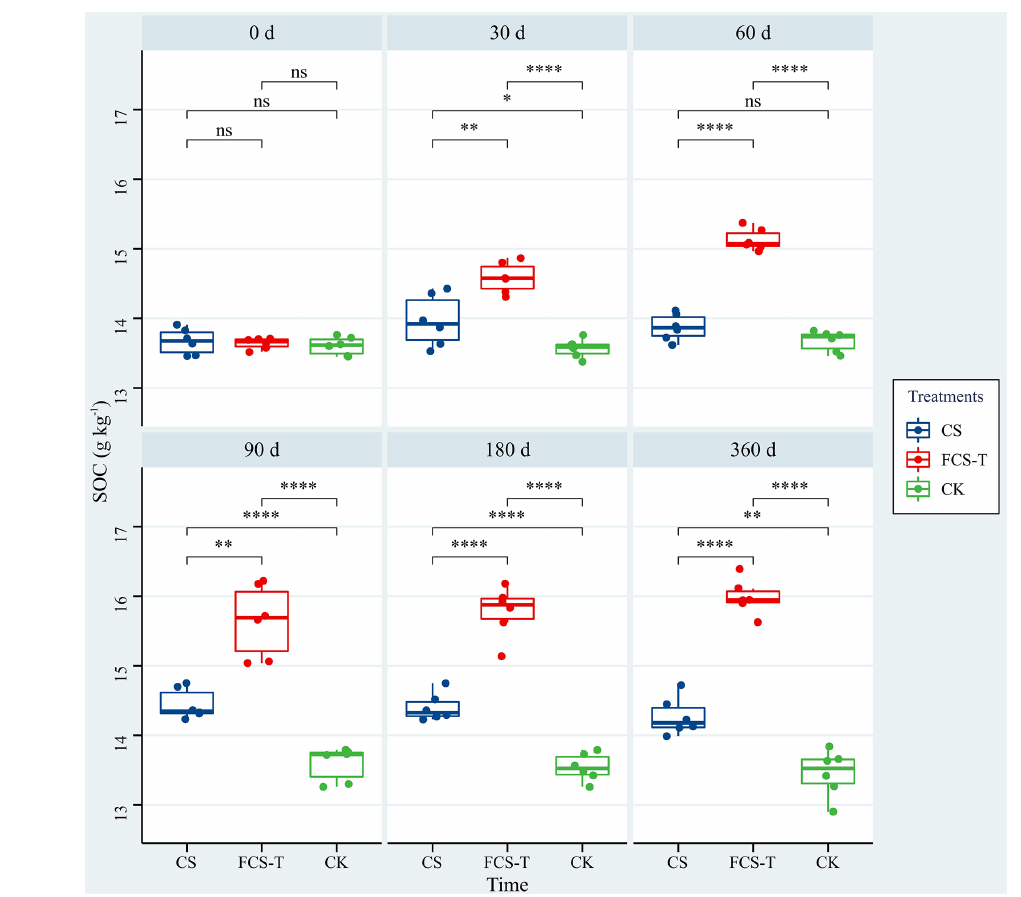
Figure 2. Soil organic carbon content of the three different treatments during the 360d experimental period. The upper, middle, and lower horizontal lines of the box represent the upper quartile, the median, and the lower quartile, respectively. The values represented by the upper- and lower-line segments refer to the maximum and minimum values of the data, and the points outside the box represent outliers. The symbol on the figure indicates the P value between two variables. The number of “ ∗ ” indicates the degree of significance. For example, “ ∗ ” means P < 0 . 05, “ ∗∗ ” means P < 0 . 01, “ ∗∗∗ ” means P < 0 . 001, ‘ ∗∗∗∗ ” means P < 0 . 0001, and “ns” means no significance. CS, corn